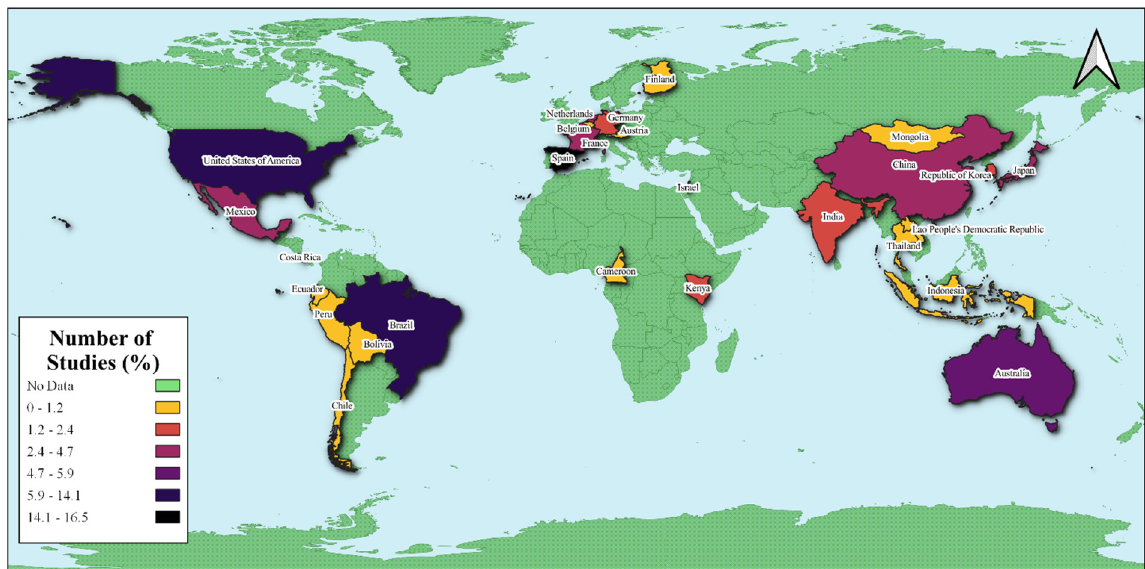
Figure 1. Geographical distributions of the reviewed studies on seed dispersal mechanisms in a changing environment.